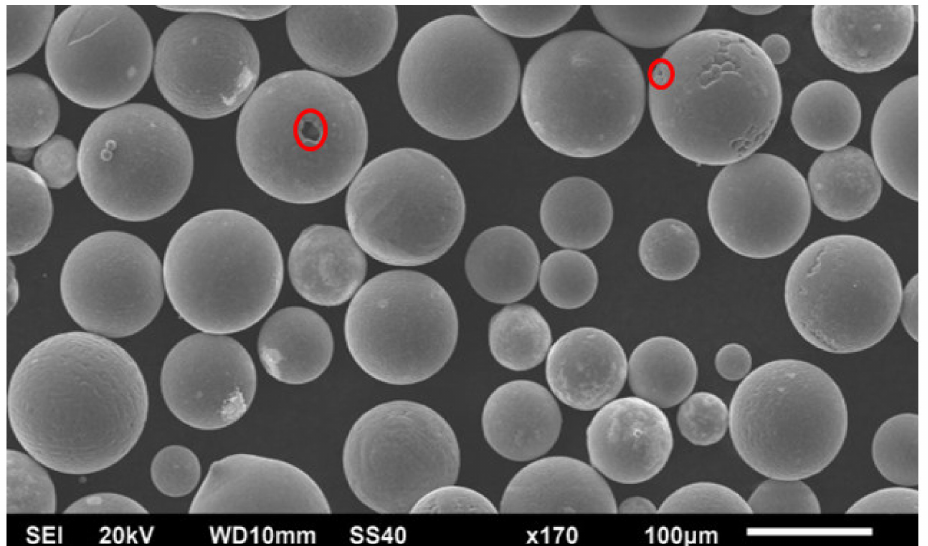
Figure 5. SEM secondary-electron image displaying an isolated pore on the surface of a particle circled in